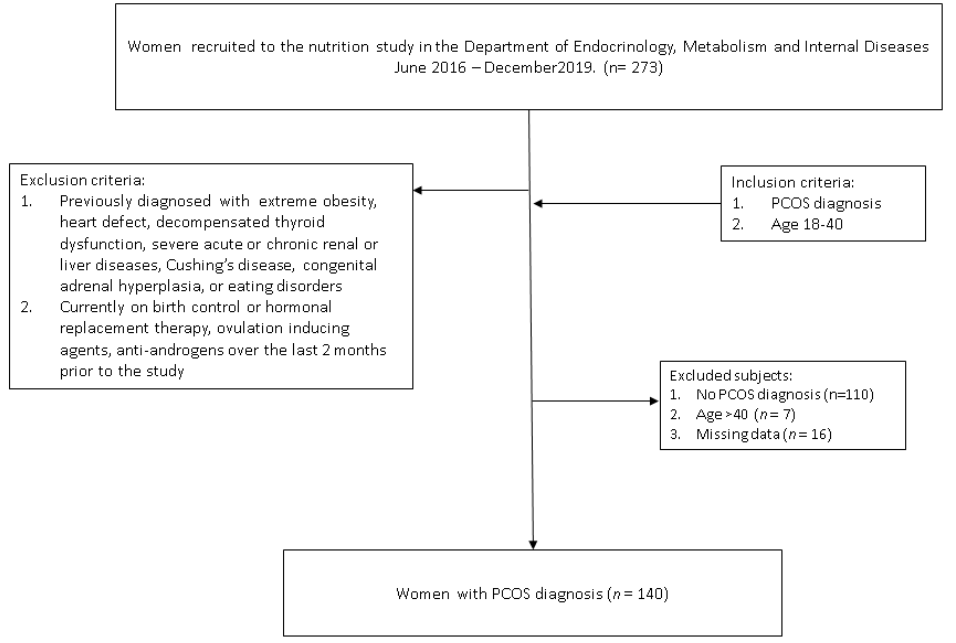
Figure 1. Flowchart of the